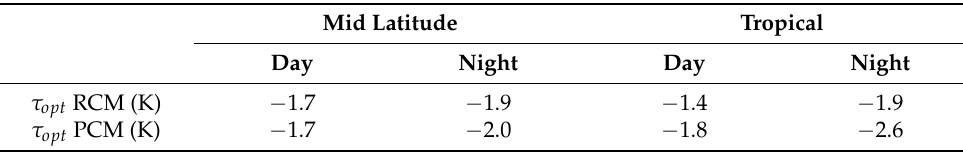
Table 4. Optimal thresholds τ